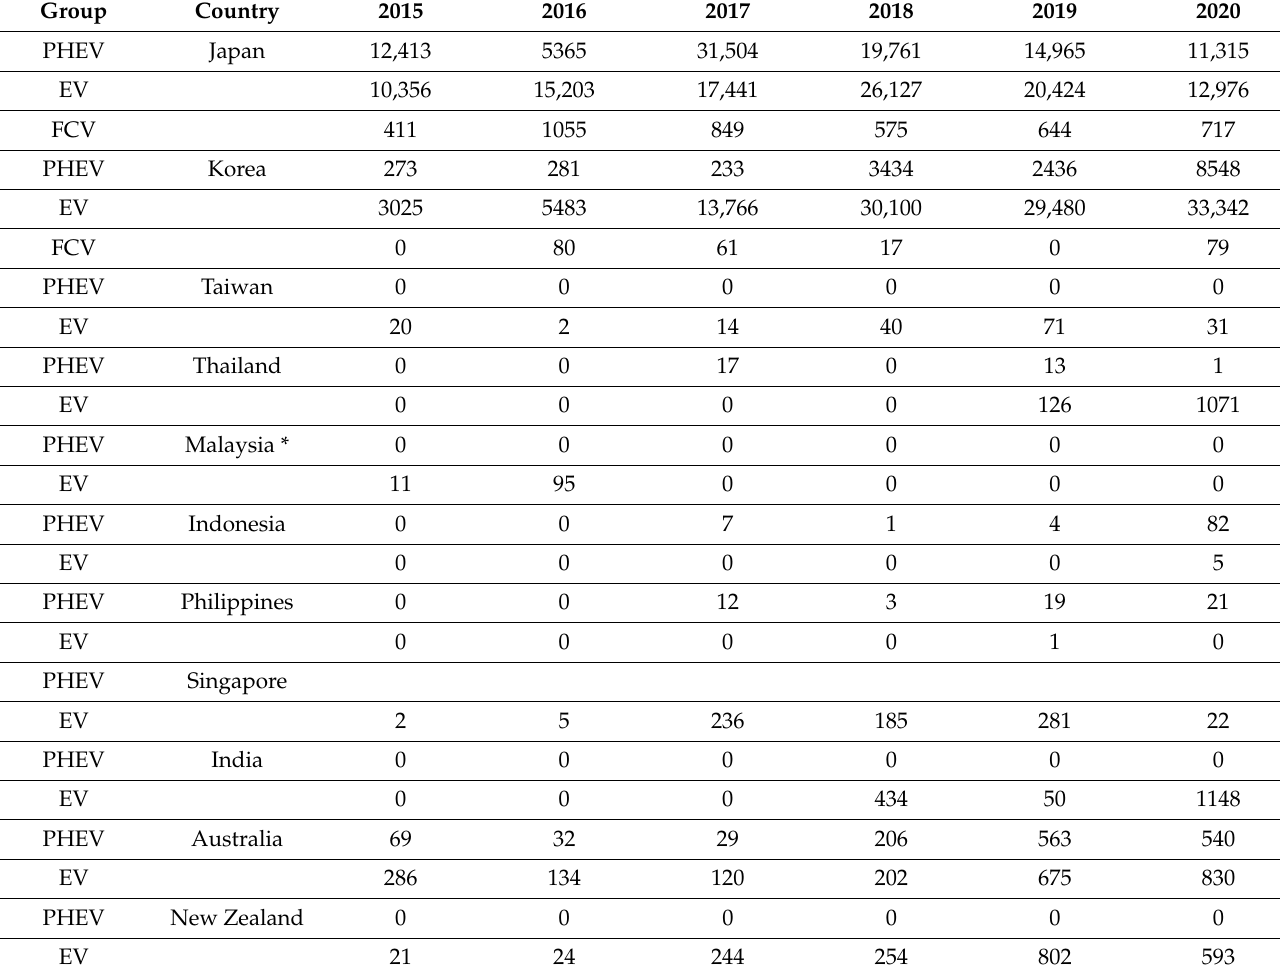
Table 1. Sales volume in selected ASEAN countries and countries of the